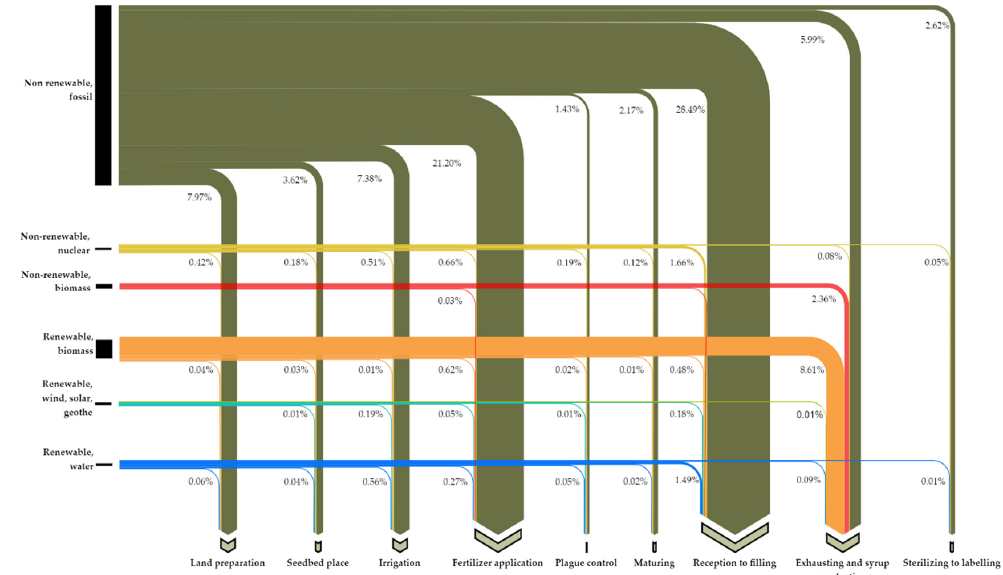
Figure 11. The energy footprint of pineapples in syrup by main unit processes.